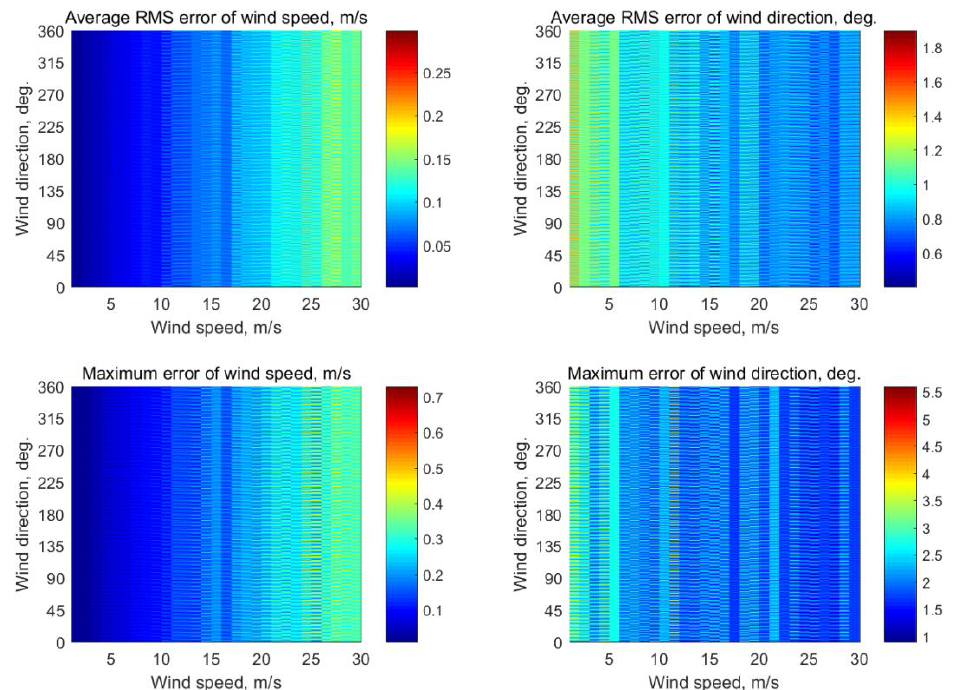
Figure A10. Simulation results of the use of two incidence angles of 40° and 45° for wind retrieval.